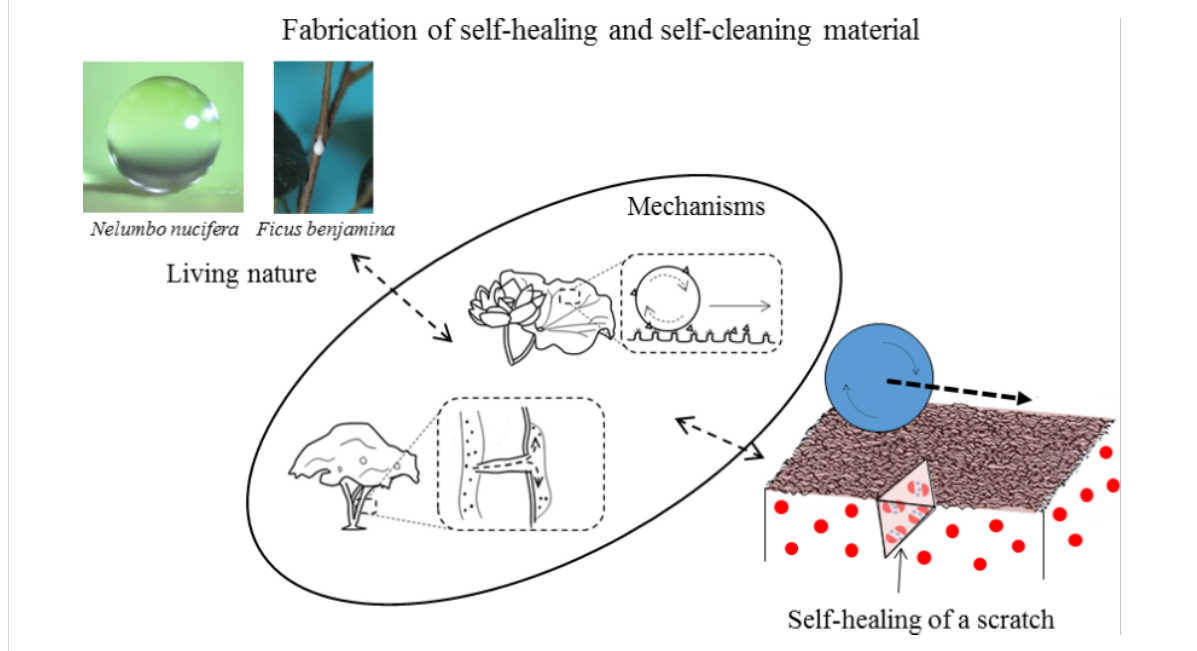
Figure 12: Translation of healing in nature into self-cleaning and self-healing materials. Mechanisms in nature, the self-cleaning lotus leaf and vascular cells of the weeping fig tree, can be translated into a new self-cleaning, self-healing material based on replenishable functional surfaces and targeted capsule delivery of self-healing materials that also preserve the functionality of the surface. Upper left images reproduced with permission from (left) [32], copyright 2009 The Royal Society, and (right) [73], copyright 2010 WIT